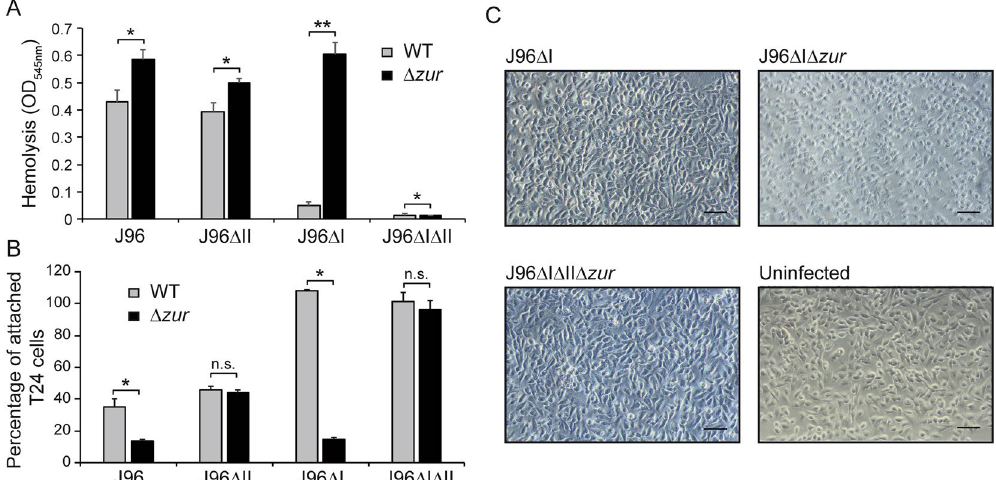
Figure 3. Effect of zur mutation in UPEC virulence-associated phenotypes. ( A ) Hemolysis after 1 hour infection of sheep blood cell suspensions with J96, JFV21 (J96 Δ I), JFV16 (J96 Δ II) and EV64 (J96 Δ I Δ II) strains and their otherwise isogenic zur mutants (EV27, EV34, EV38 and EV65). The release of haemoglobin was monitored by OD 545 nm . ( B ) T24 cell monolayer detachment activity. Percentage of remaining attached T24 cells, measured as OD 590 nm , after 3.5 h post-infection with the same strains as in ( A ) Mean values with standard deviation from three independent experiments ( A ) and three biological replicates ( B ) are plotted. * P < 0.05 ** P < 0.0001 n.s.: non-significant, t test with p-values adjusted by Bonferroni’s method ( C ) Phase contrast microscopy of T24 bladder epithelial cell monolayers infected for 2 hours with the indicated strains. Scale bar, 0.1 mm.